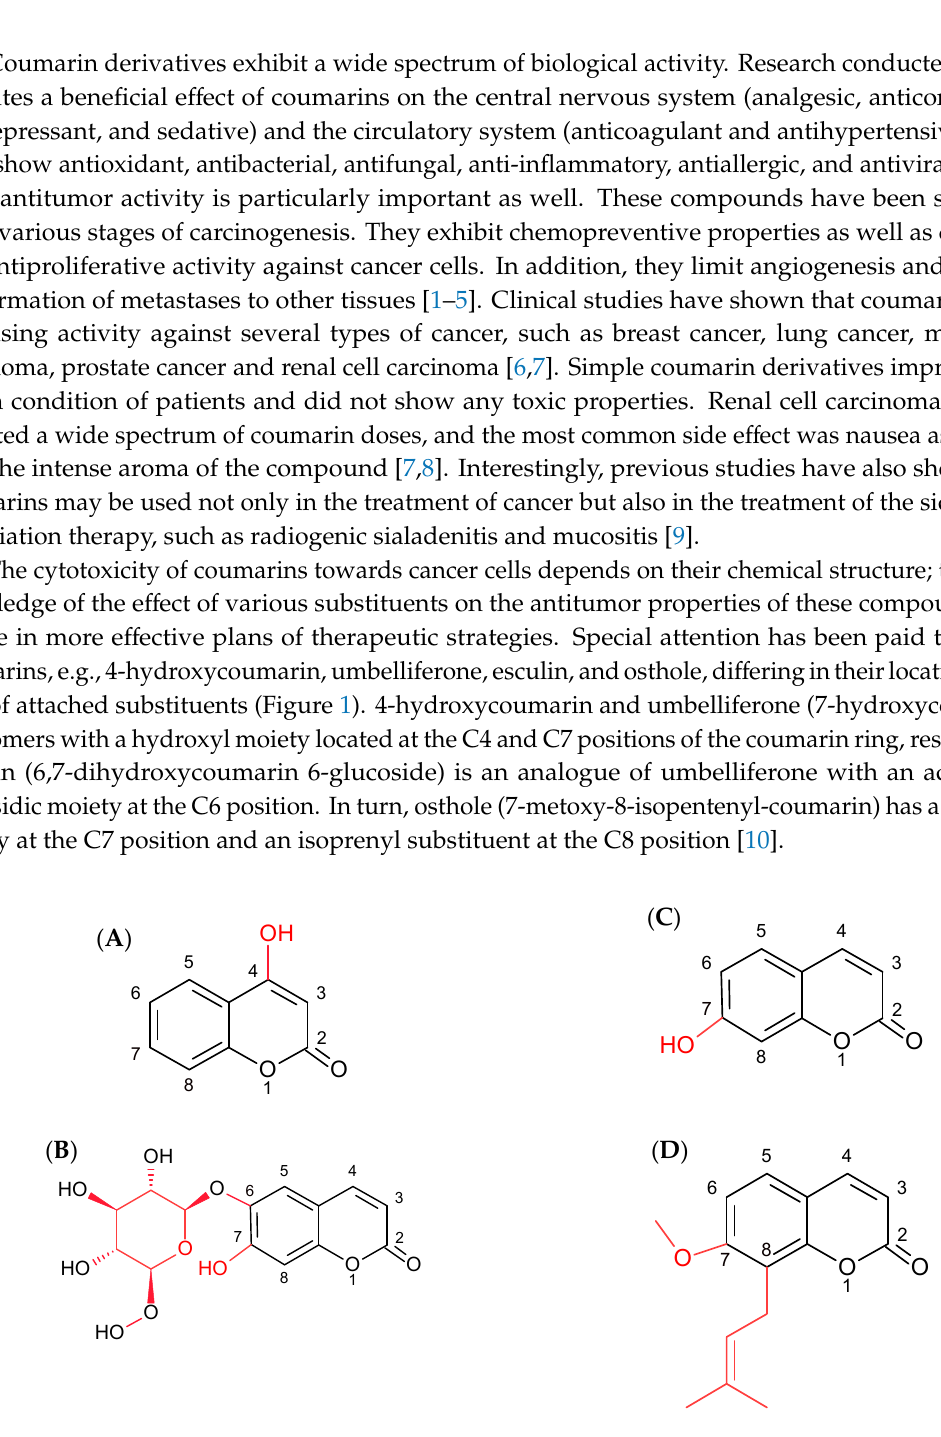
Figure 1. Structure of 4-hydroxycoumarin ( A ), esculin ( B ), umbelliferone ( C ) and osthole ( D